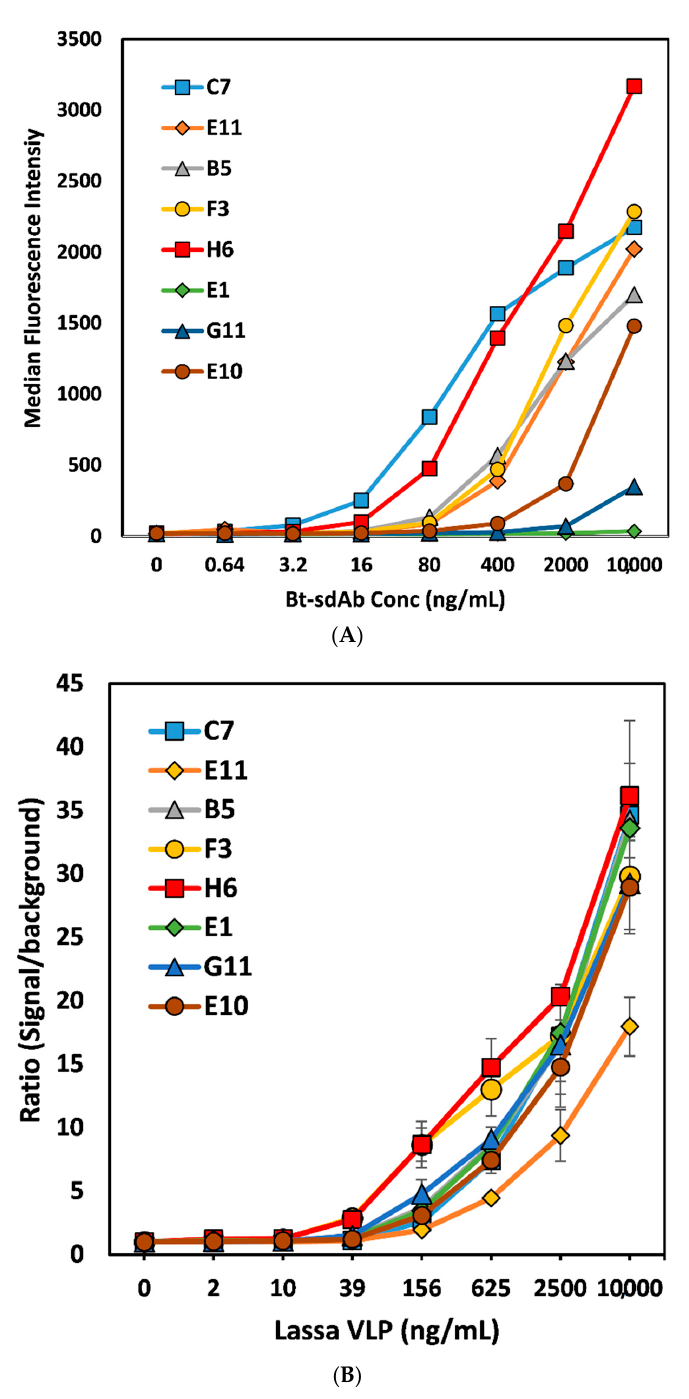
Figure 2. ( A ): MagPlex direct binding assay, where Lassa NPn was immobilized on MagPlex magnetic microspheres and biotinylated sdAb allowed to bind at different concentrations, followed by addition of SA-PE. ( B ): Homogeneous MagPlex sandwich fluoroimmunoassay; each sdAb was immobilized on a set of MagPlex magnetic microspheres and incubated in the presence of Lassa VLPs and biotinylated sdAb H6 and SA-PE. The amount of SA-PE bound to each microsphere set was evaluated following a single wash step. This experiment was repeated on three separate days in triplicate. Shown is the average of the three replicates from one experiment; the error bars represent the standard deviation of the